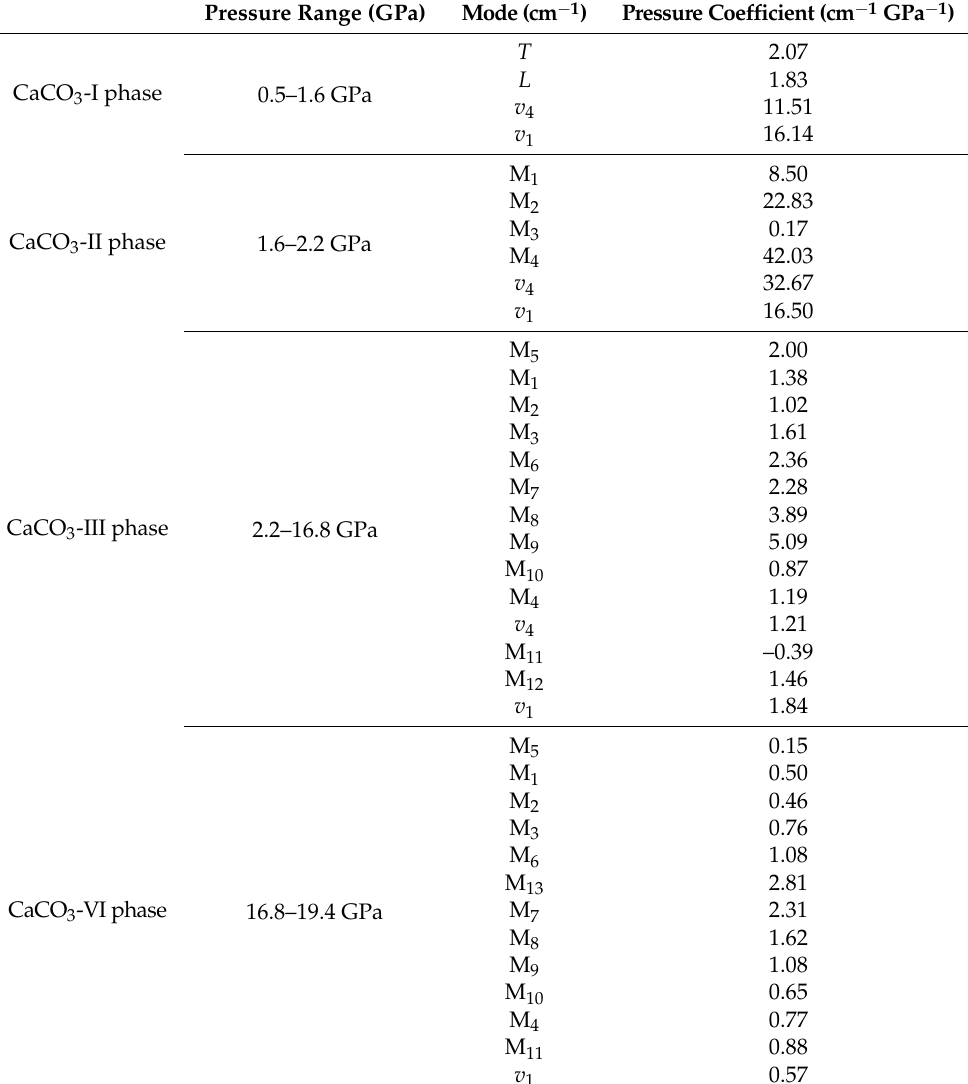
Table 1. Pressure coefficients of the Raman modes of CaCO 3 -I, CaCO 3 -II, CaCO 3 -III, and CaCO 3 -VI phases upon compression within the pressure range from 0.5–19.4 GPa at room